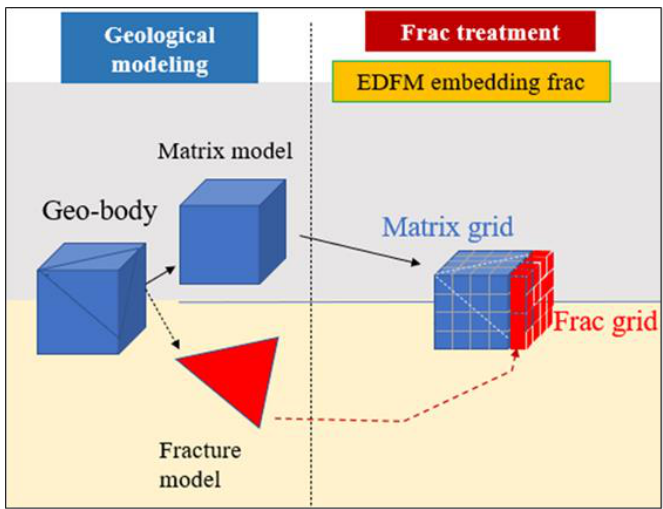
Figure 2. Schematic 3D representation of simple EDFM methodology example, which depicts how a non-orthogonal fracture is embedded in the matrix grid blocks.